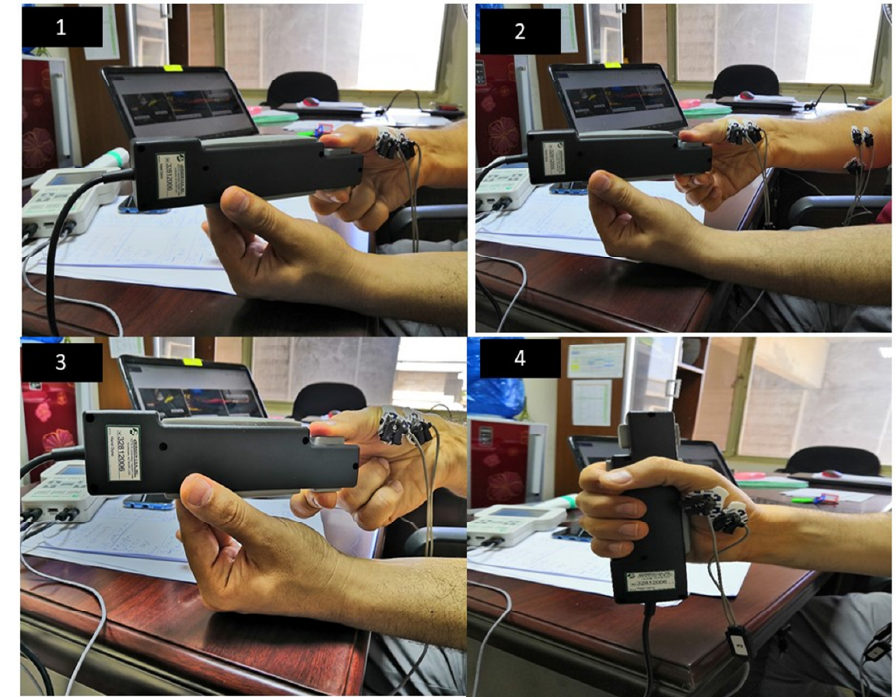
Fig. 3. Four types of hand movements: 1. fine pinch with thumb and index fingers. 2. tripod with thumb, index and middle fingers. 3. Thumb middle pinch with thumb and middle fingers. 4. power